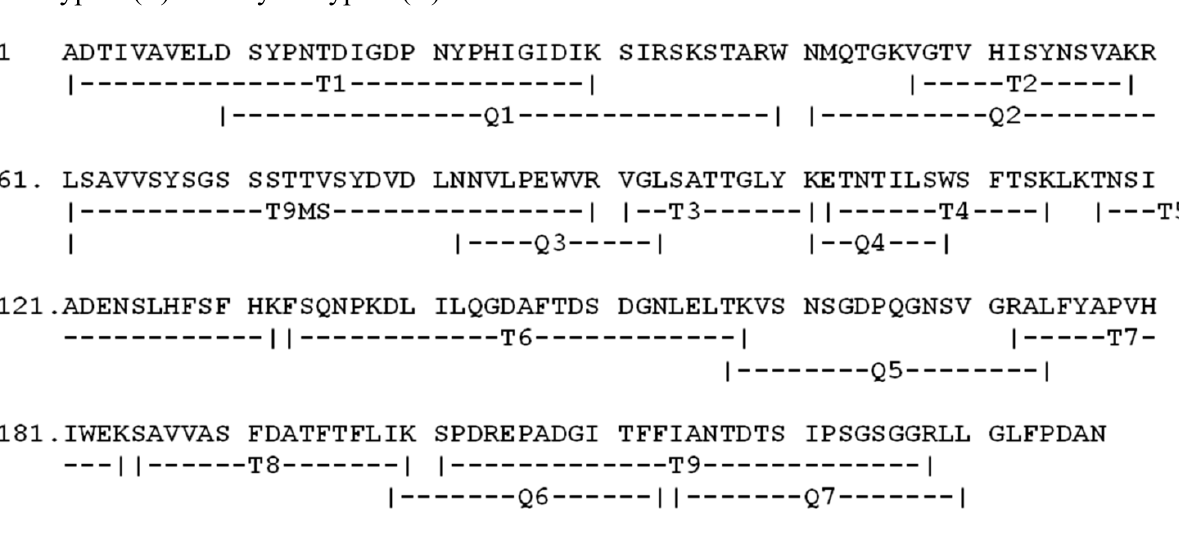
Figure 4. Complete amino acid sequence of lectin from the seeds of Dioclea wilsonii (DwL). Peptide fragments obtained by degradation of DwL with the endoproteinases trypsin (T) and chymotrypsin